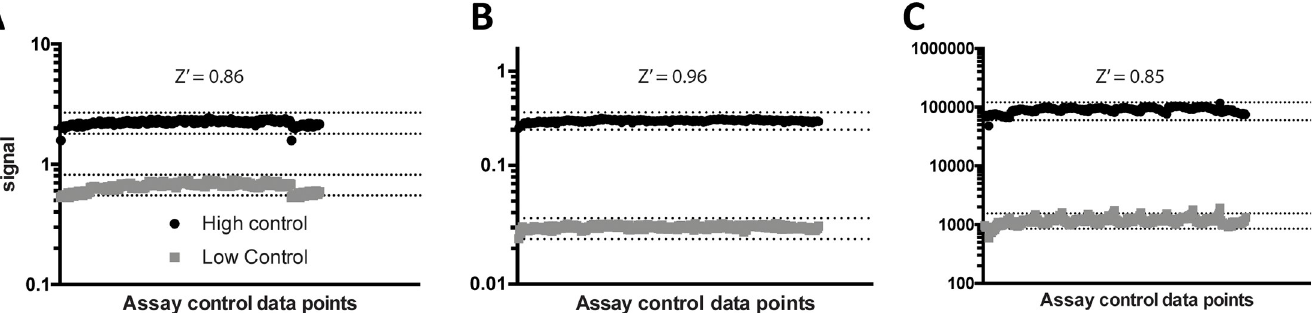
Fig 6. High and low control signal performance in pilot screening. Results for the (A) CisBio, (B) LANCE, and (C) AlphaScreen assays shown. Individual signal data points from neutral control (+CD47, +SIRP α , no inhibitor) and low control (+CD47 -SIRP α , no inhibitor) plotted by well for each plate in the 10-plate pilot screening run (n = 32 points per plate). Dotted lines represent + and– 20% of average signal for each high and low control. The Z’ factor was calculated from the high and low controls on each plate and averaged across all plates.